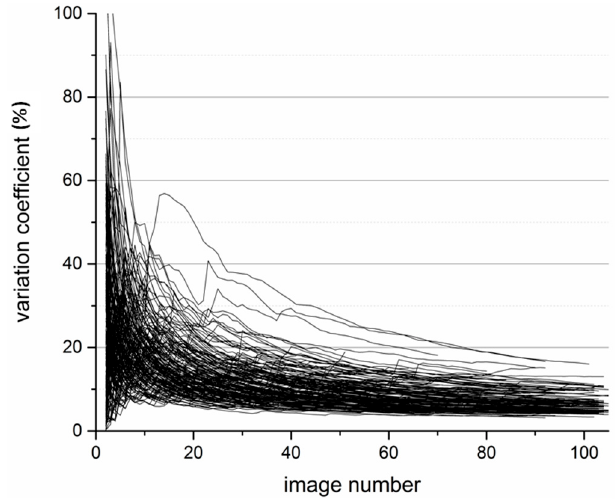
Figure 3. Decrease of the variation coefficient in dependence of the image number.